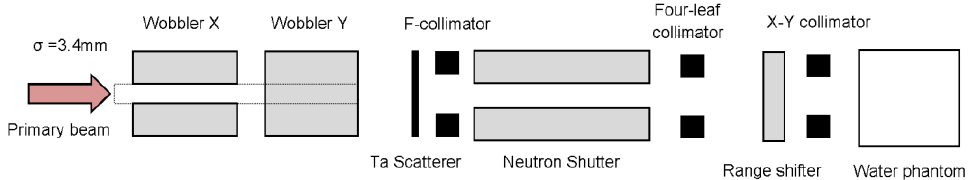
Figure 12. Diagram of the HIMAC biological beamline (not to scale) [32].